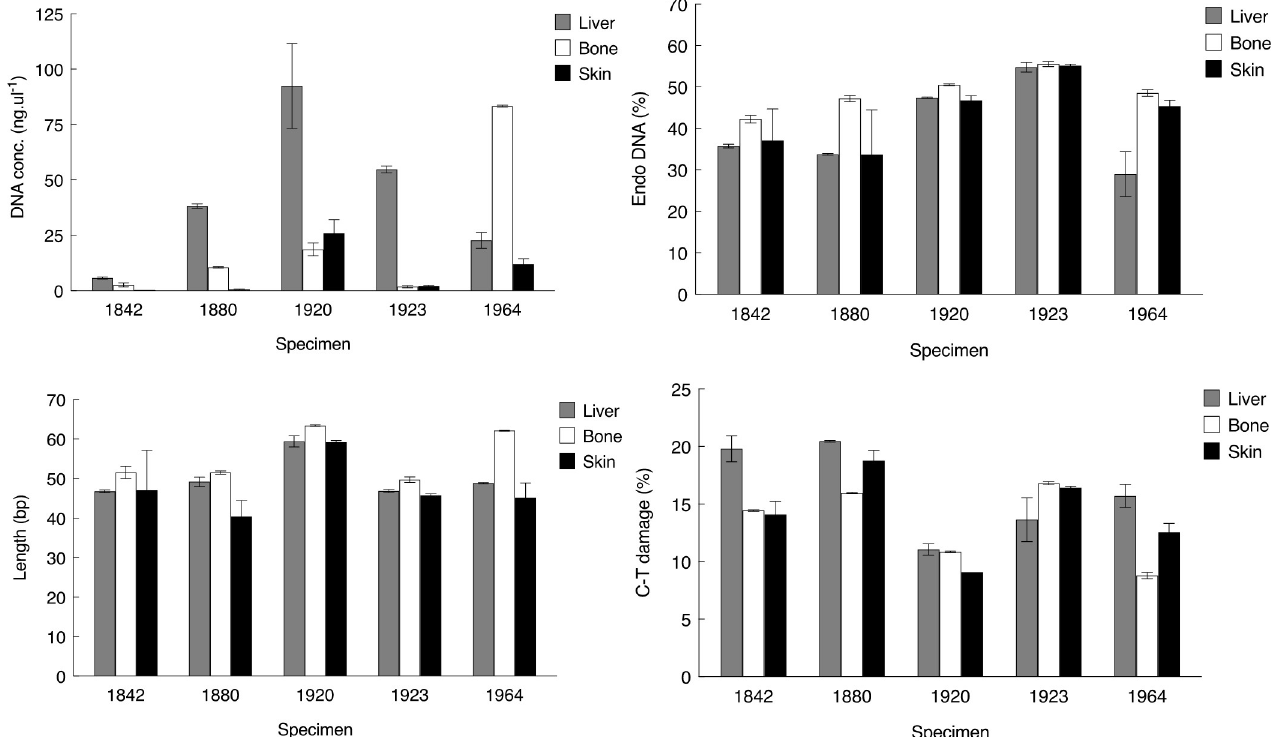
Fig 1. DNA preservation. DNA concentration measurement and DNA preservation metrics listed according to specimen age. Endo % , endogenous DNA content; Length , average length (in base pairs) of mapped reads; C-T % , C-to-T deamination damage fraction recorded at first position in the 5’end. Bars represent average values of two replicate DNA extracts with the range